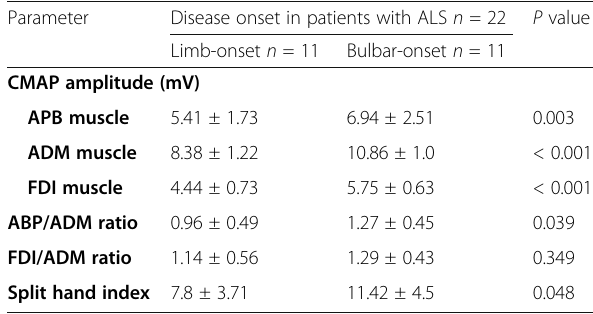
Table 5 The CMAP amplitude and split hand index in limb- onset versus bulbar-onset patients with ALS Parameter Disease onset in patients with ALS n = 22